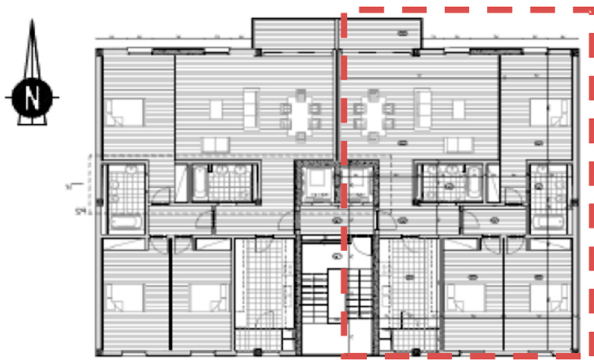
Figure 2. Residential flat model used in the study (right). Table 1. Designation, thickness and thermal performance (U-Value) of the ETICS applied.